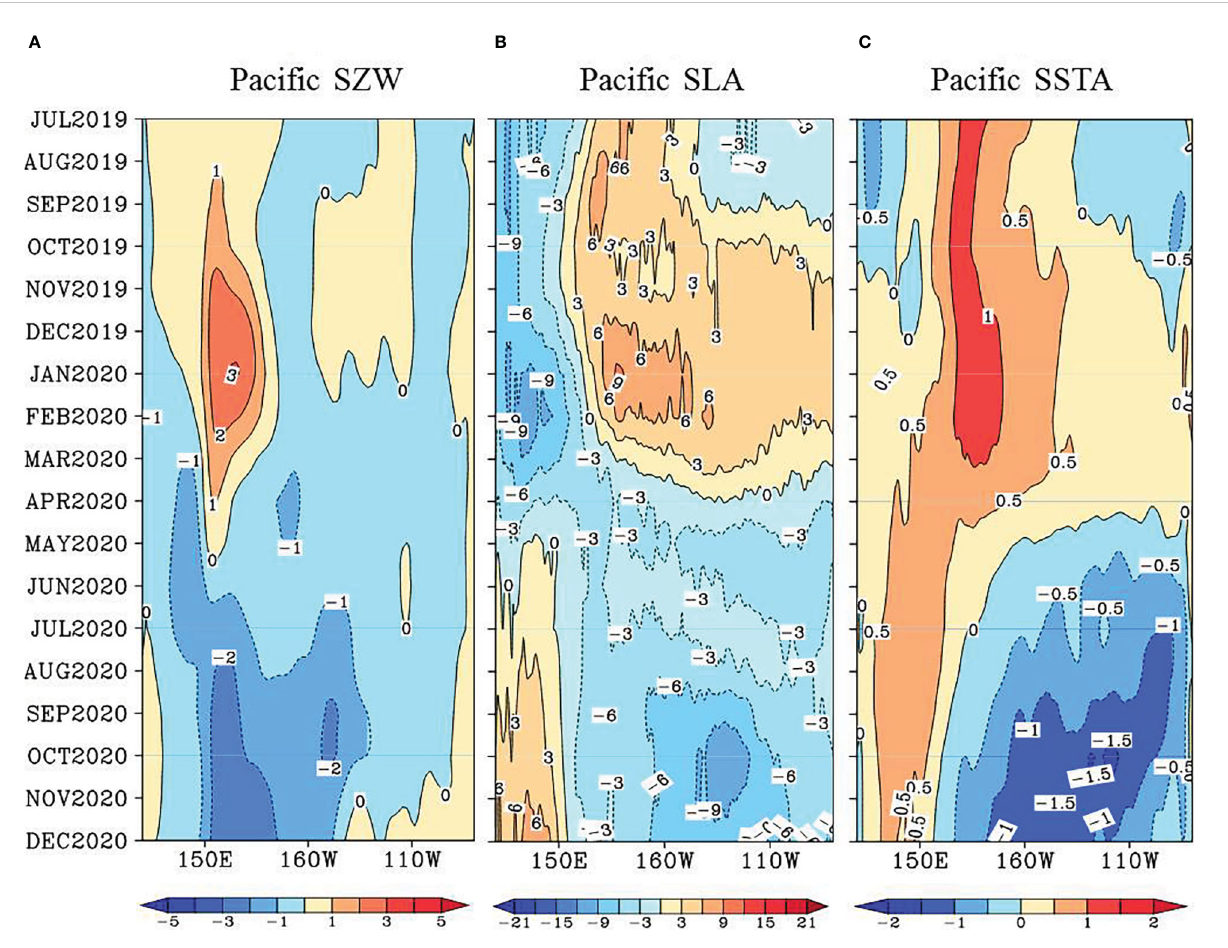
FIGURE 7 Evolution characteristics of 2020/2021 La Niña event. Longitude-time plots of observed monthly anomalies of (A) SZW (ms -1 ) over the equatorial Paci fi c Ocean (5°S-5°N), (B) SLA (cm) over the equatorial Paci fi c Ocean (1°S-1°N), and (C) SSTA (°C) over the equatorial Paci fi c Ocean